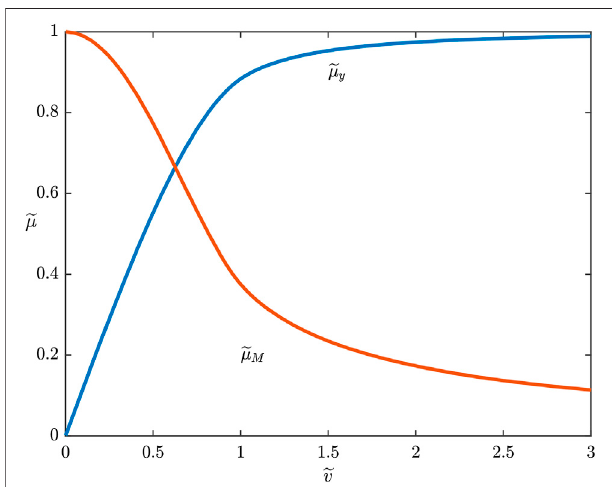
FIGURE 4 | Theoretical prediction of the dependency of the macroscopic coef fi cient of friction on the dimensionless velocity for added continuous rotational (bore) movement to a Hertzian Indenter according to Eqs 21 and 22 . The frictional resistances on both the forward motion and on the rotational torque are reduced.